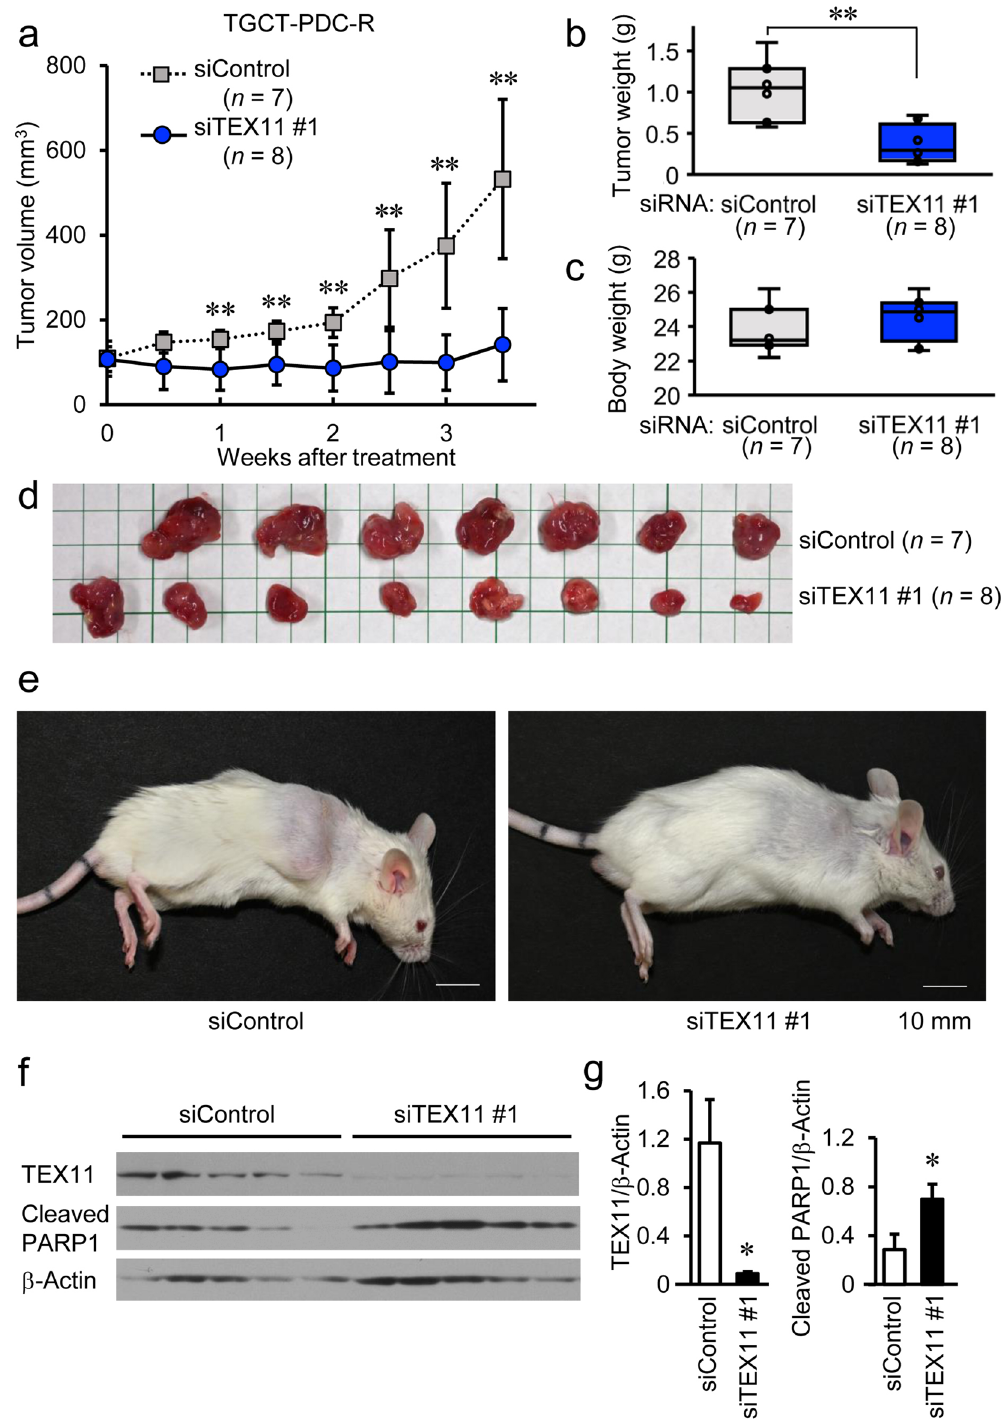
Figure 4. TEX11-specific siRNA injection significantly represses the development of TGCT-PDC-R-derived xenograft tumors in severely immunodeficient mice treated with cisplatin. (a) Volumes of tumors generated by TGCT-PDC-R cells in 7-week male NOD/SCID mice treated with intratumoral injection of control (siControl) or TEX11 -specific (siTEX11) siRNAs plus intraperitoneal cisplatin administration. (b) Weights of tumors generated by TGCT-PDC-R in mice treated with injection of indicated siRNAs plus cisplatin administration. (c) Body weights of tumor-bearing mice treated with injection of indicated siRNAs plus cisplatin administration. Results are shown as mean ± SE. **, P < 0.01. (d) Images of dissected tumors at the endpoint. (e) Representative images of tumor-bearing mice at the endpoint. (f) Immunoblotting of TEX11 and cleaved PARP1 in dissected TGCT-PDC-R tumors. β-actin was used as a loading control. (g) Relative expression of TEX11 and cleaved PARP1 normalized to β-actin expression analyzed by densitometry. Results are shown as mean ± SE (n = 5). *, P < 0.05, **, P <